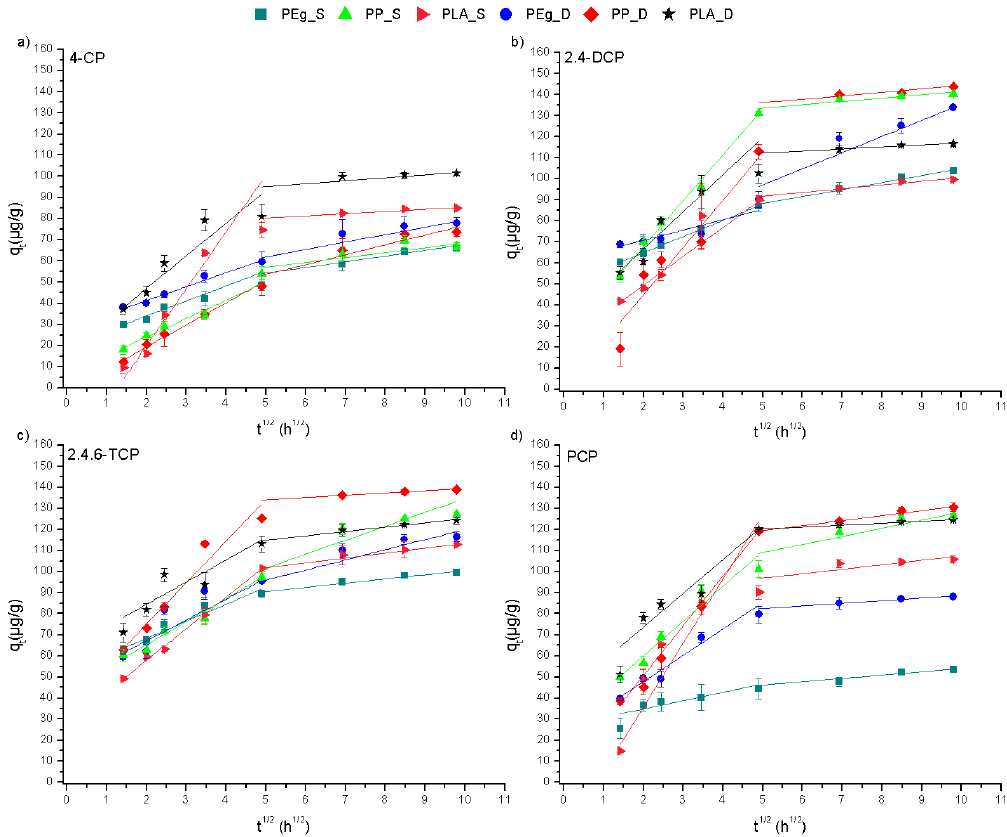
Figure 3. Plots for the sorption kinetics, based on the Weber–Morris model, of ( a ) 4- CP; ( b ) 2,4-DCP; ( c ) 2,4,6-TCP and ( d ) PCP on PEg, PP and PLA particles in the synthetic matrix (PEg_S, PP_S and PLA_S) and Danube river water (PEg_D, PP_D and PLA_D) (n = 3, mean value ±SD).